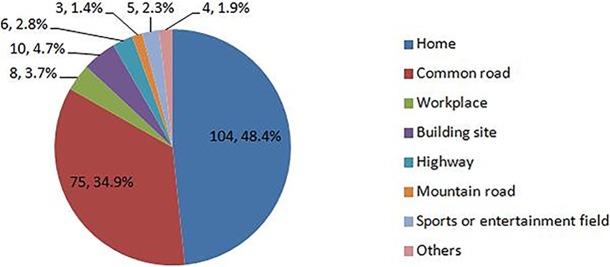
The detailed mechanism for low-energy fractures.